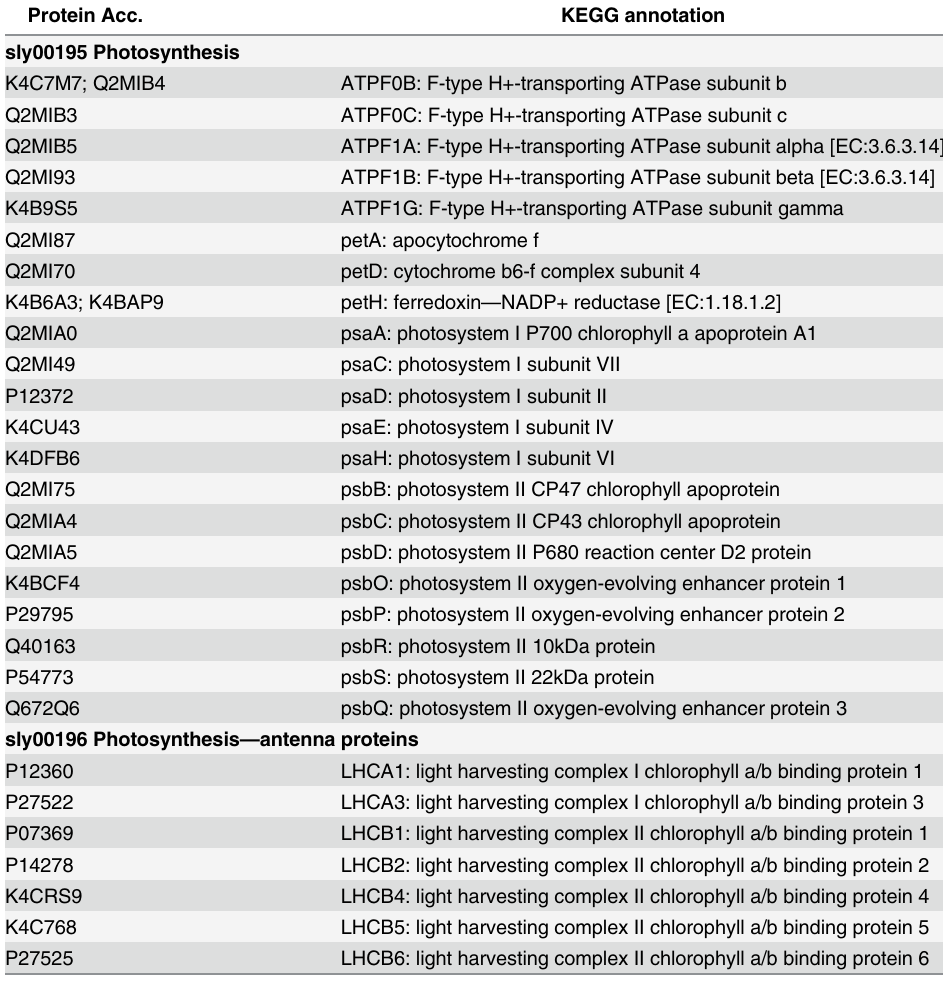
Table 2. Succinylated proteins involved in photosynthesis pathway. Protein